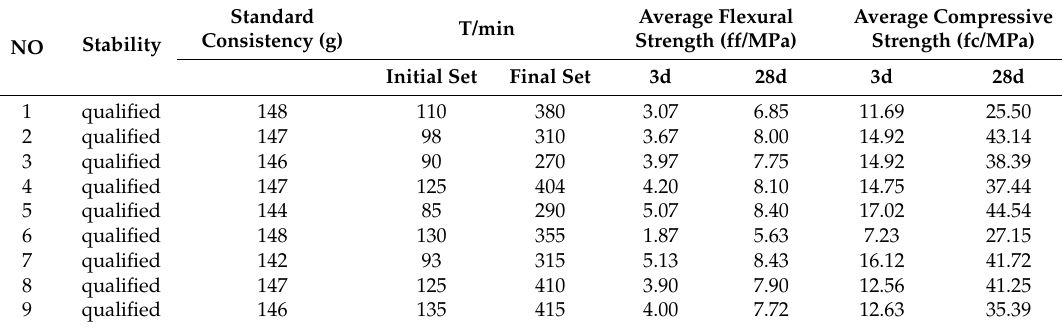
Table 5. Physico-mechanical parameters of the curing agent with different mix